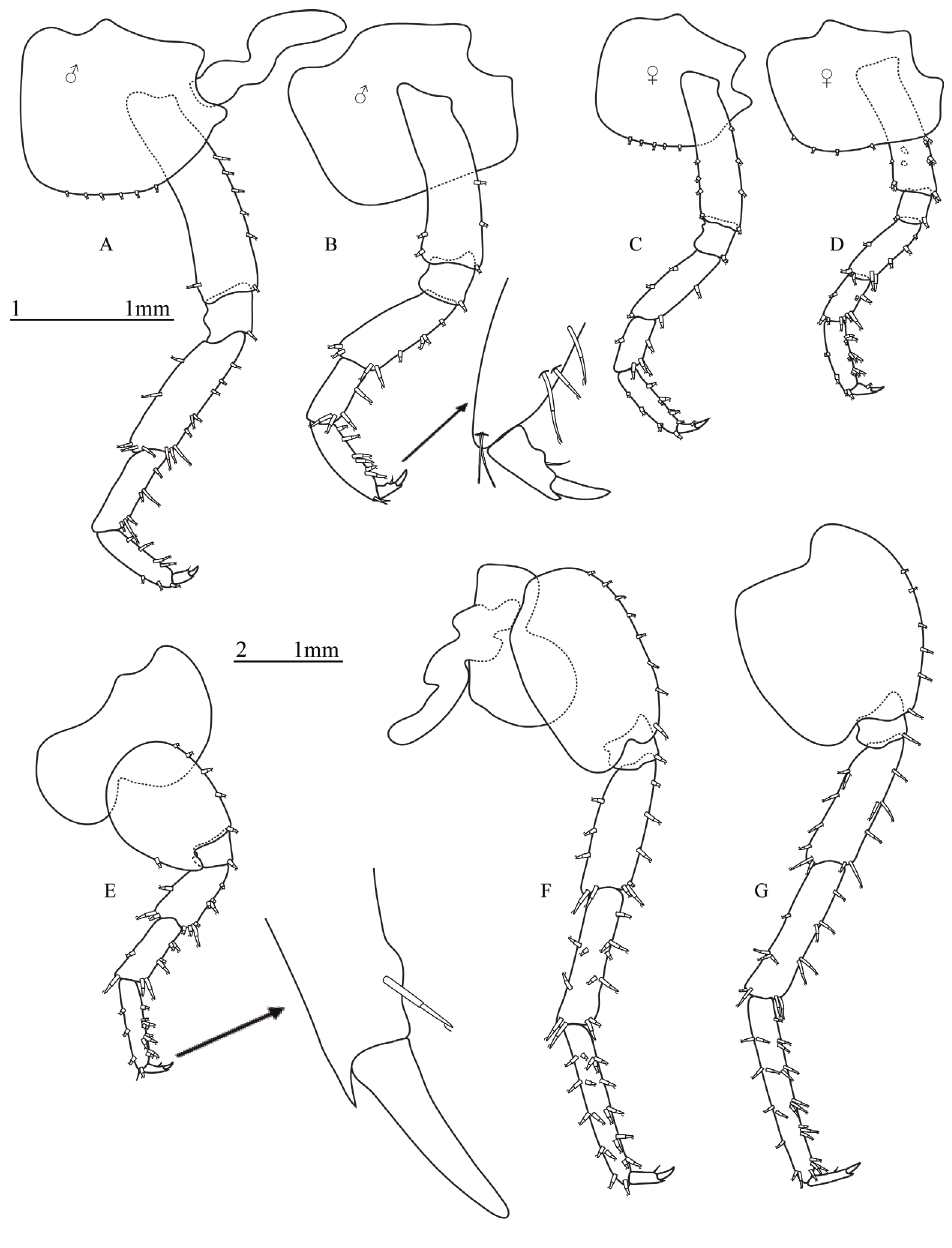
Fig. 4. Cerrorchestia taboukeli sp. nov. A–B, E–G . Holotype, ♂, 11.3 mm, MNHN-IU-2019-2276. C–D . Paratype, ♀, 9.6 mm, MNHN-IU-2019-2278. A . Pereopod 3 (scale 1). B . Pereopod 4 (scale 1). C . Pereopod 3 (scale 1). D . Pereopod 4 (scale 1). E . Pereopod 5 (scale 2). F . Pereopod 6 (scale 2). G . Pereopod 7 (scale